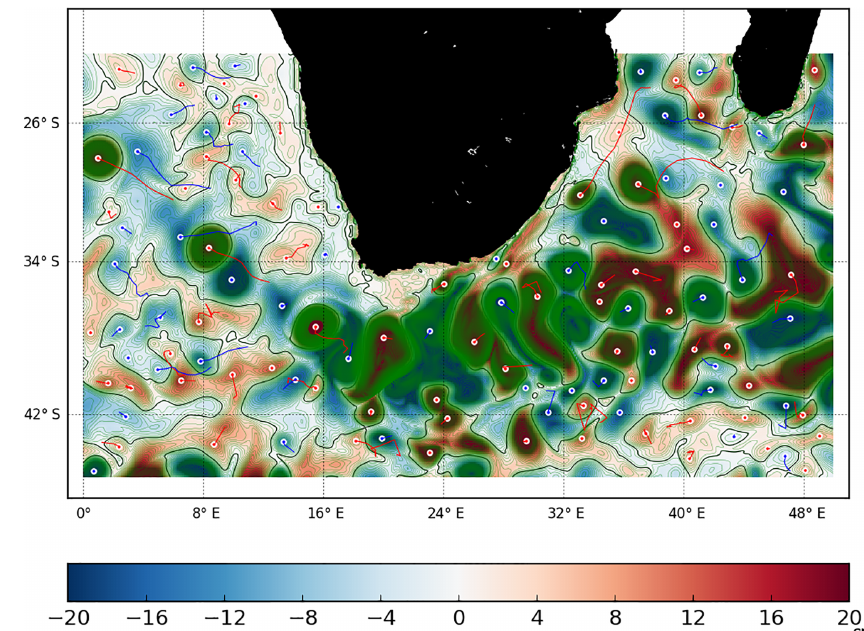
Figure 20. Output of the online eddy-tracking application using data from a running POP simulation, showing a region around the southern tip of Africa. The green lines show the contours between areas of different sea level anomaly values. Red indicates areas of elevated sea level, and is used to detect anticyclonic eddies. Similarly, blue indicates a lower sea level and is used to identify cyclonic eddies. The red or blue lines indicate the track that an eddy has traveled since it was first